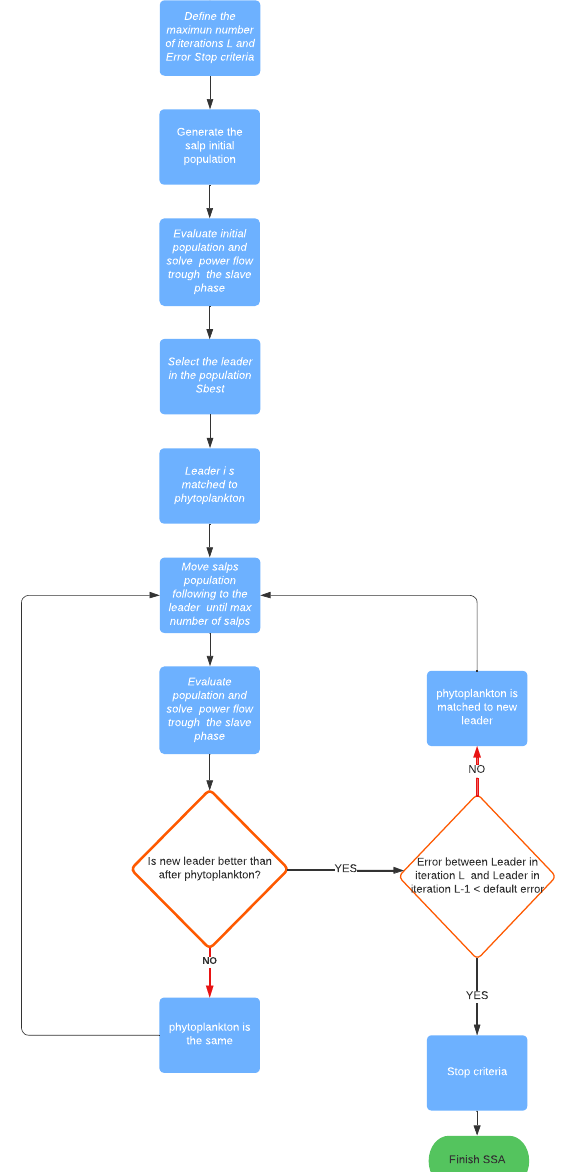
2. Agrega y organiza figuras según sea necesario. Consejo pro: Activa mosaico automático (en la pestaña de configuración de página a la derecha del lienzo) para permitir que el lienzo se ajuste automáticamente.